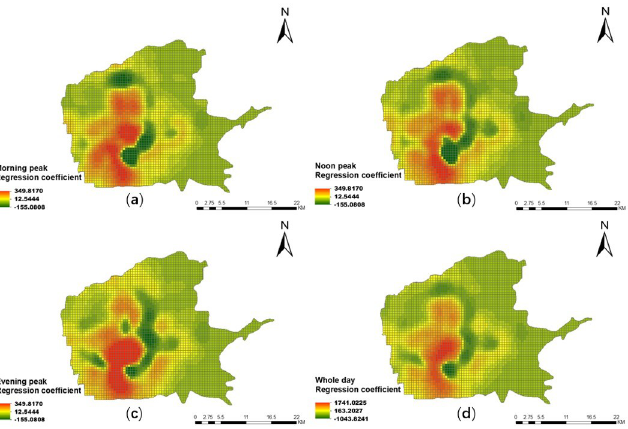
Fig 13. Spatial distribution of coefficient of the mixed degree of urban functions in different periods on weekends. (a) Morning peak; (b) noon peak; (c) evening peak; (d) whole day.